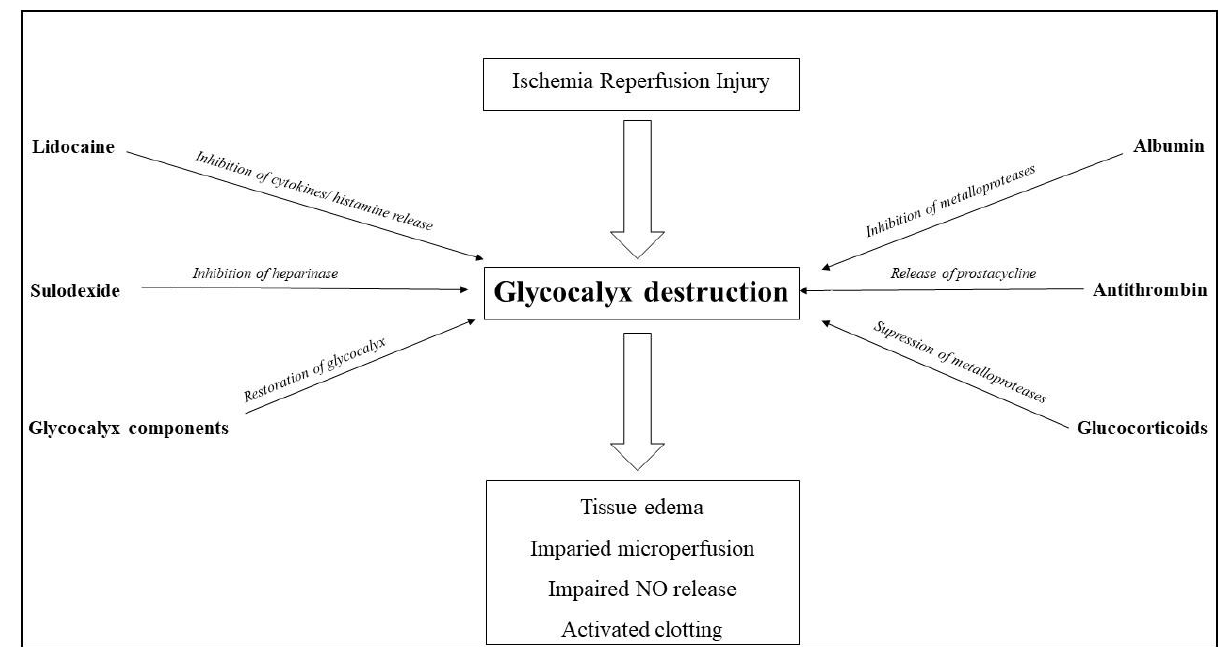
Figure 2. Glycocalyx-protective mechanisms.